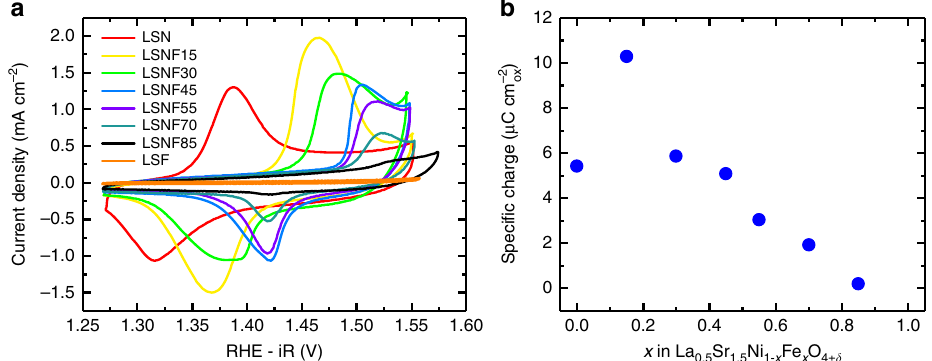
Fig. 4 Cyclic voltammetry (CV) of LSNF catalysts in O 2 -saturated 0.1 M KOH. a CVs of LSNF at 100 mV s − 1 revealing a systematic anodic shift in Ni 2 + /3 + oxidation/intercalation potentials with increasing Fe substitution. CVs at 100 mV s − 1 , taken after 3 – 4 cycles, are depicted to aid the reader in distinguishing peak potential shifts and relative areas, but at 100 mV s − 1 contributions to E P from capacitance and mass transport resistance cannot be ignored. To address this, peak potentials reported in Supplementary Figure 8c were taken from stable CVs at 10 mV s − 1 . b Speci fi c oxidative charge ( µ C cm − 2 oxide ) resulting from the integration of oxidation waves. Integrations were performed using speci fi c current density ( µ A cm − 2 oxide ) to normalize differences in catalyst surface area (Supplementary Figure 8d). The OER baselines for stable CVs at 10 mV s − 1 were fi t and subtracted. Supplementary Figure 14 contains